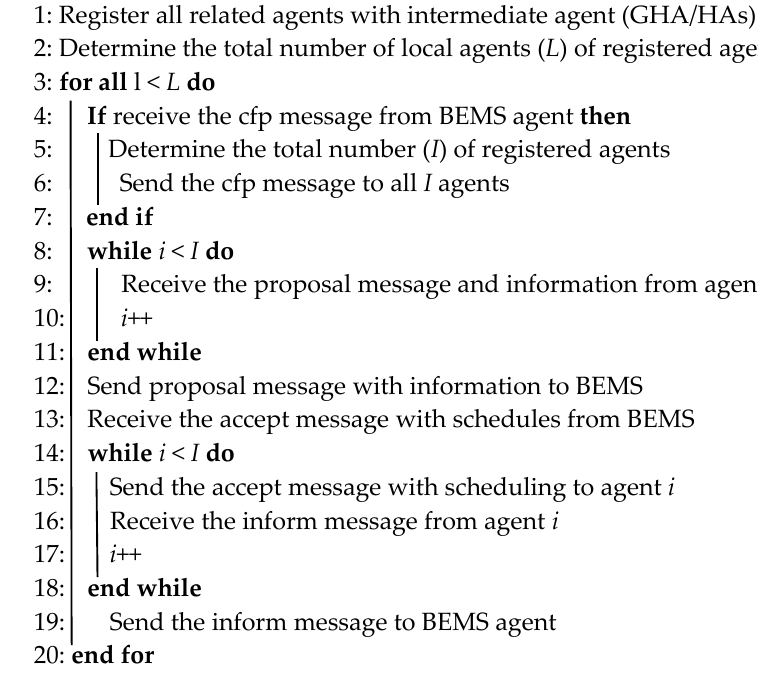
Algorithm 2. Communication among intermediate agents and local agents using MCNP.